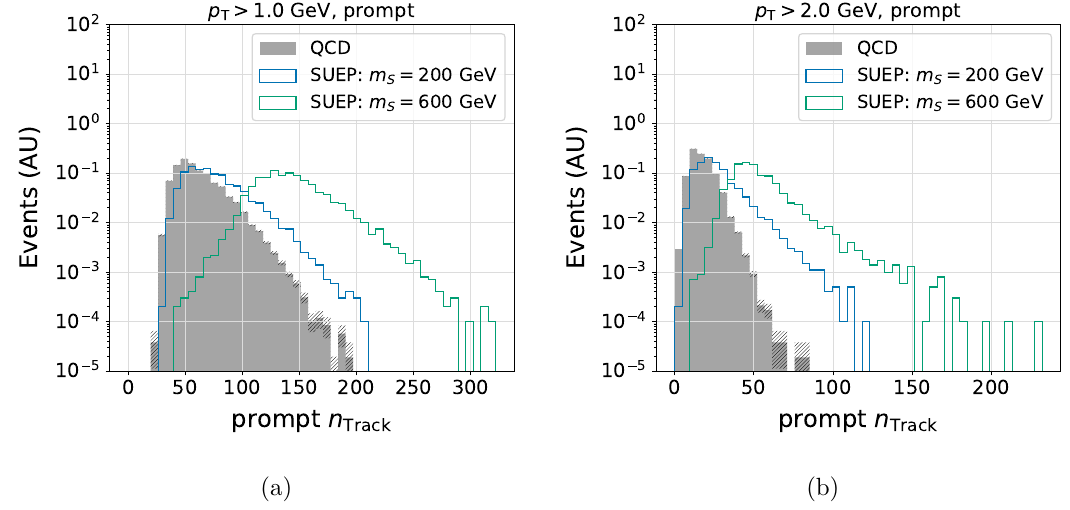
Figure 22. The number of prompt tracks with p T > 1 GeV (a) and p T > 2 GeV (b) for minimum bias and representative SUEP signal samples at pile-up 200. Slashed bands on the QCD distribution represent the statistical